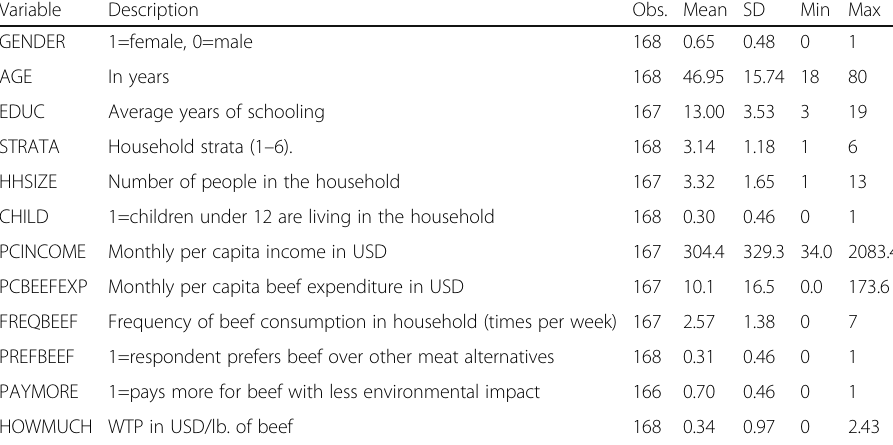
Table 2 Stage 1 — CV summary